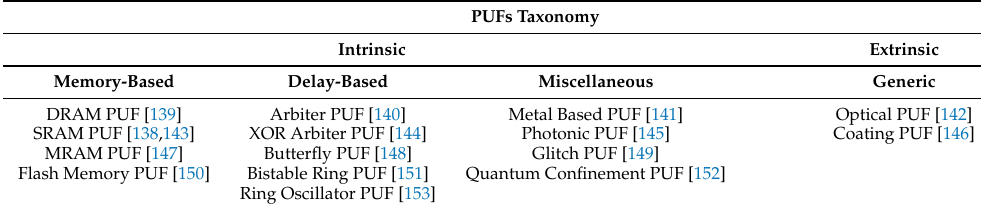
Table 3. PUFs Taxonomy based on Origin of